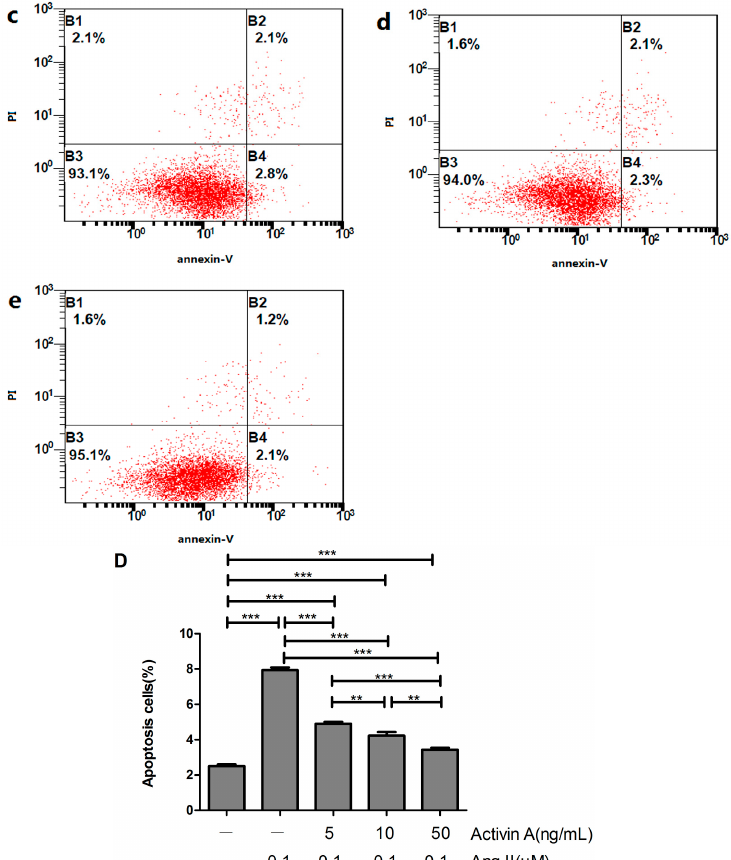
Figure 8. Expression levels of follistatin and ERS-related molecules in Ang II-stimulated H9c2 cells cultured with a low concentration of activin A. ( A ) Western blot was performed to determine the expression of follistatin and ERS-related molecules. Proteins were extracted from H9c2 cells, separated by sodium dodecyl sulfate − polyacrylamide gel electrophoresis, and immunoblotted sequentially with antibodies. (1) Control, (2) Ang II (0.1 μ M), (3) activin A (5 ng/mL) + Ang II (0.1 μ M), (4) activin A (10 ng/mL) + Ang II (0.1 μ M), and (5) activin A (50 ng/mL) + Ang II (0.1 μ M); ( B )